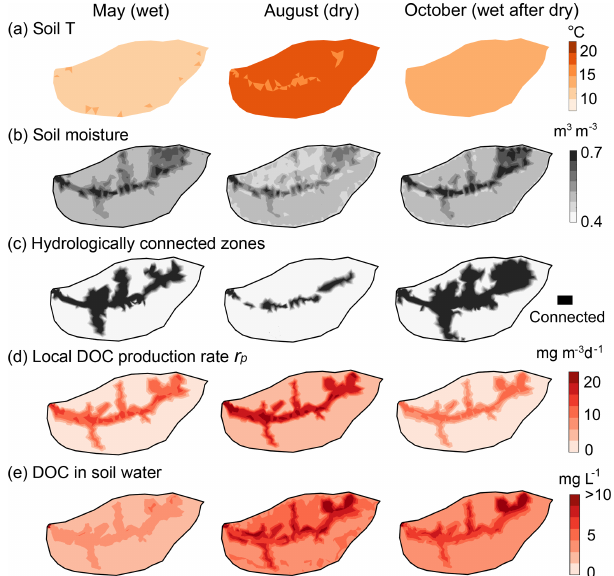
Figure 5. Spatial profiles in May (wet), August (dry), and October (wet after dry) of 2009: (a) soil T , (b) soil moisture, (c) hydro- logically connected zones, (d) local DOC production rates r p , and (e) soil water DOC concentration. The soil DOC and r p were high in swales and the valley that had a relatively high soil water and SOC content (Fig. 1c). Although water content in August was rela- tively low compared with May and October, high soil T led to high r p , with most DOC production and accumulation in zones that were disconnected from the stream.